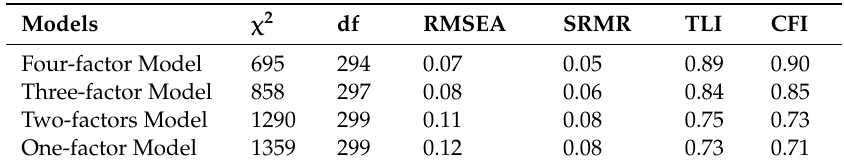
Table 1. Comparison of measurement